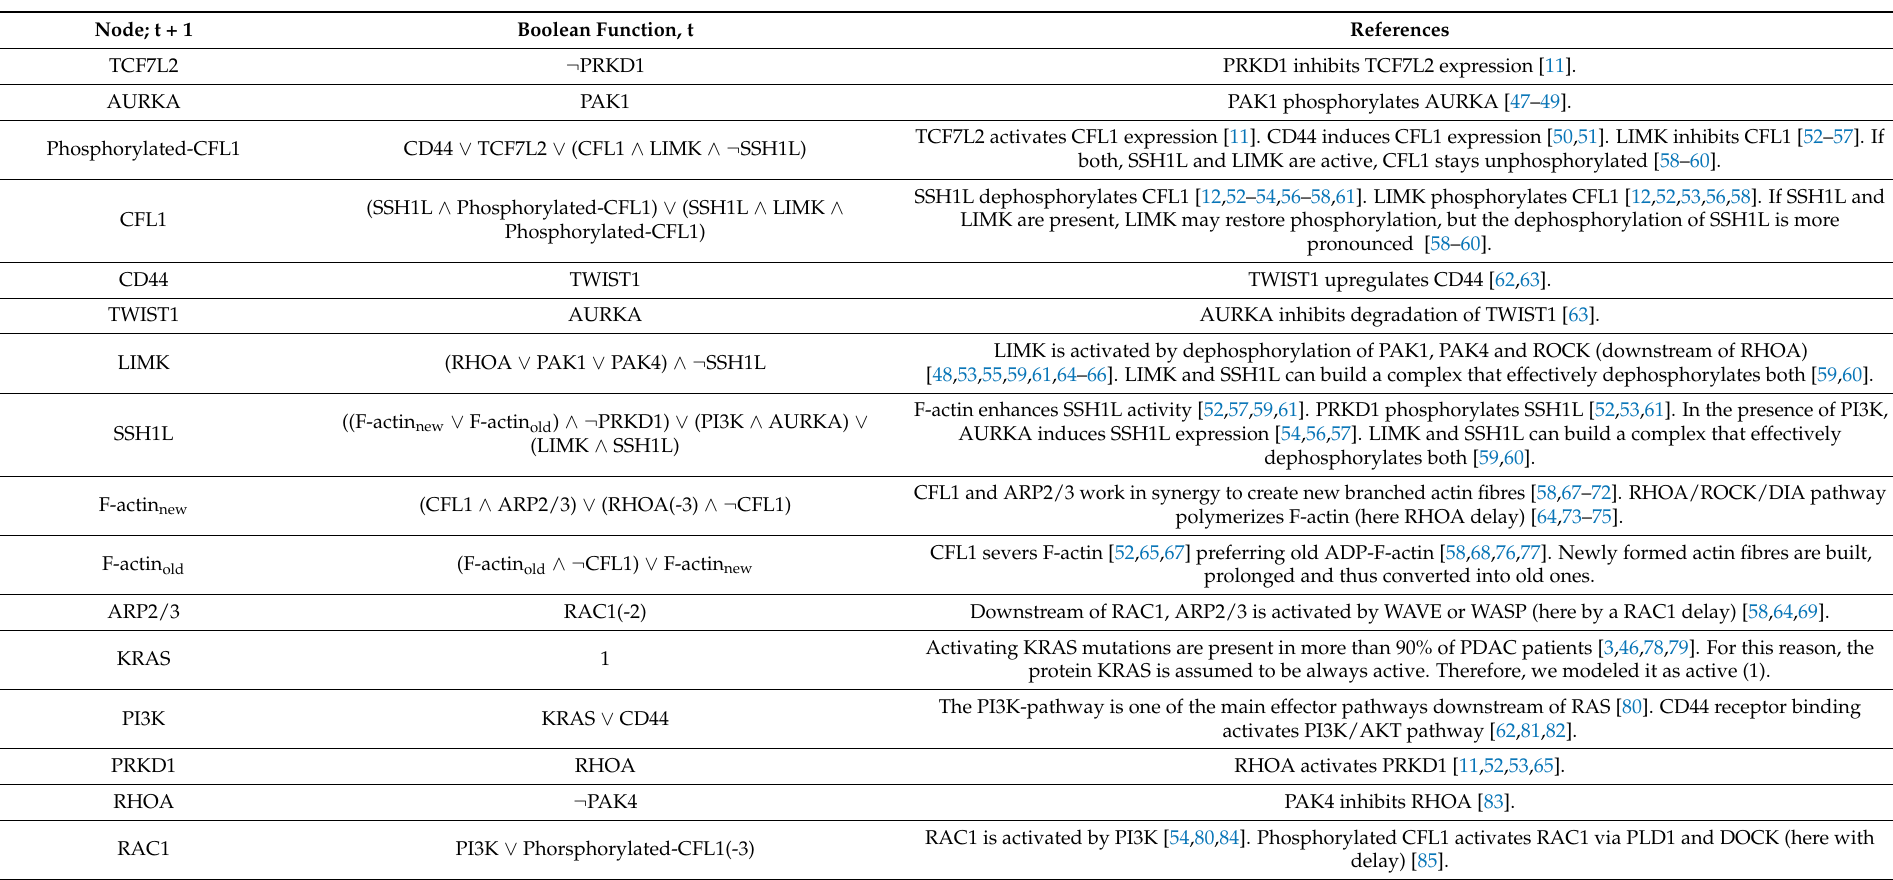
Table 1. Boolean functions of the CFL1 model. Depicted are the Boolean functions of the analyzed model. Interactions are described by logical connectives AND ( ∧ ), OR ( ∨ ), and NOT ( ¬ ). Linear interactions have been simplified by time delays ((-2) or